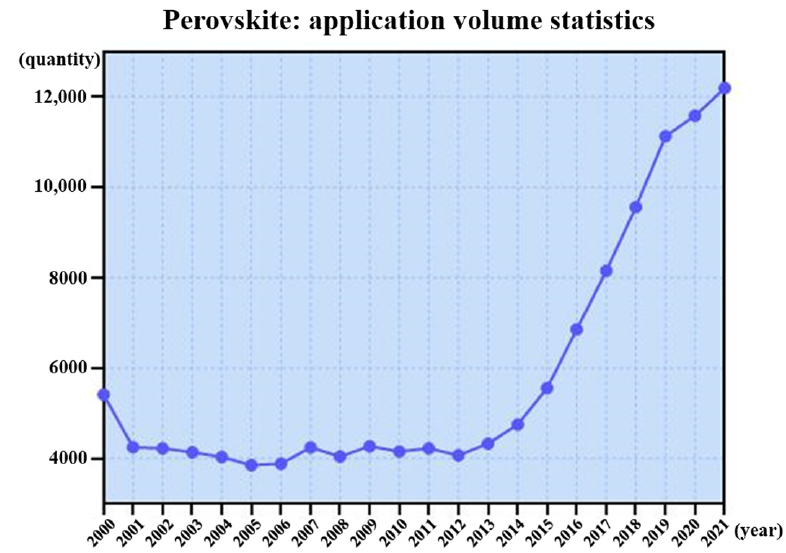
Figure 20. The research quantity of perovskites in the past two decades.